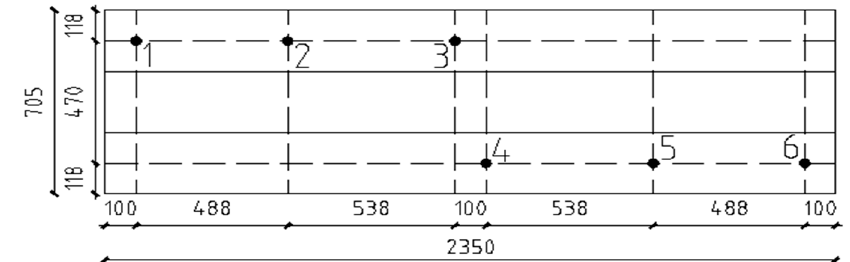
Figure 4. Location of LVDTs in test specimen.